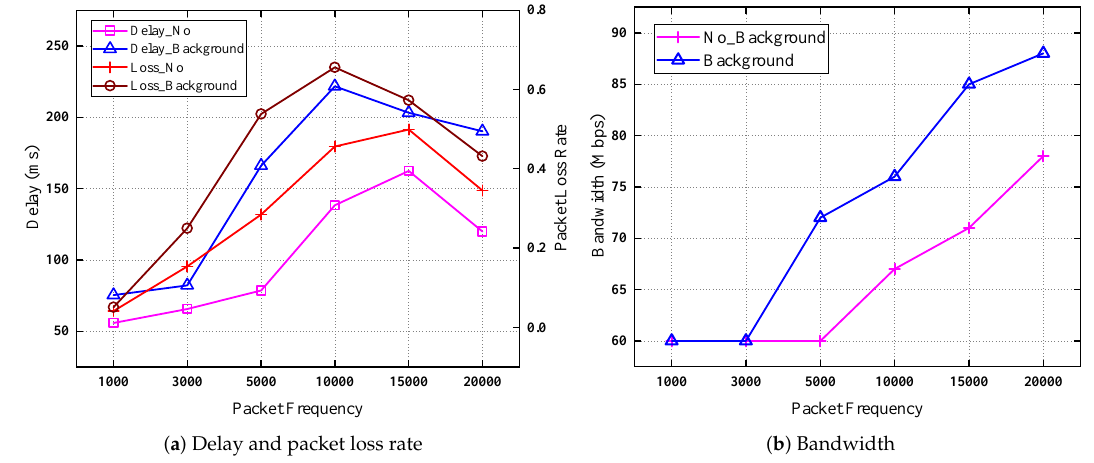
Figure 12. Background traffic and no background traffic